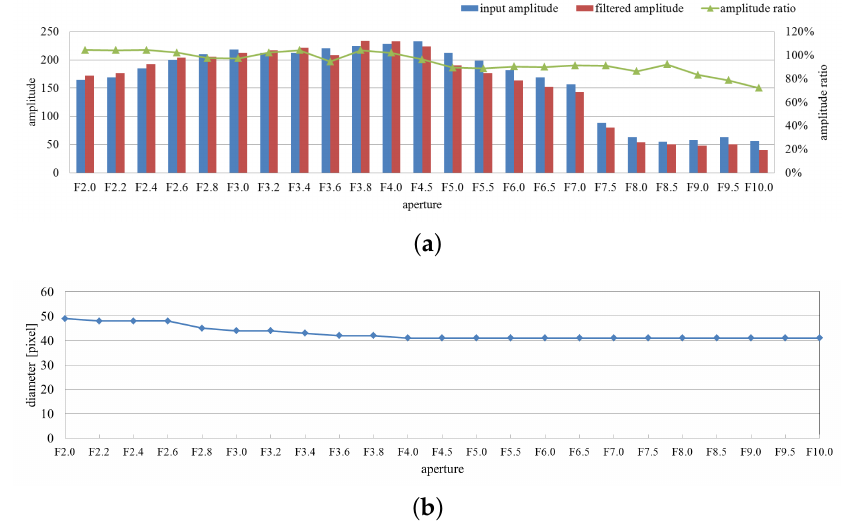
Figure 5. Averaged amplitudes and extracted region sizes with aperture variation. ( a ) Averaged amplitudes of input and pixel-wise filtered images and their ratios on the extracted pixels; ( b ) diameters of extracted vibration